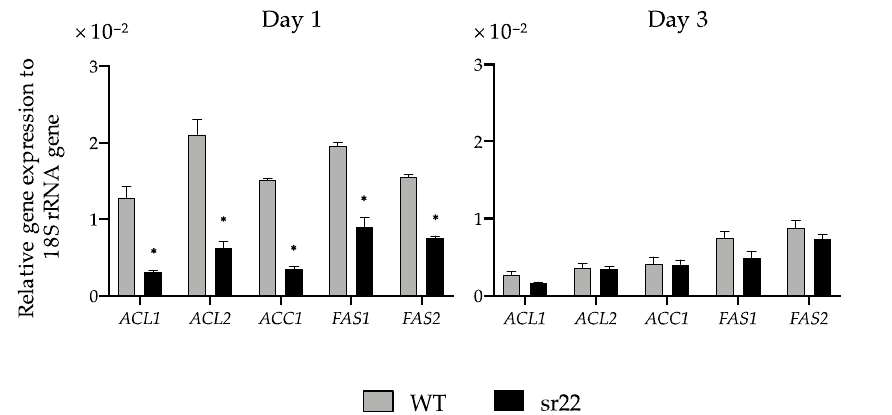
Figure 4. Relative transcription levels for citrate-mediated acyl-CoA synthesis pathway of sr22 compared with the wild-type strain (WT). WT and sr22 were cultured on an S medium at 30 °C for nine days in a large-scale culture. Symbols: gray bars, WT; black bars, sr22. The transcription levels with relative quantitative method normalized by 18S rRNA. The data are indicated as the mean ± SEM of the three independent experiments. Asterisks indicate statistically significant differences between WT and sr22 ( t -test; * p < 0.05).